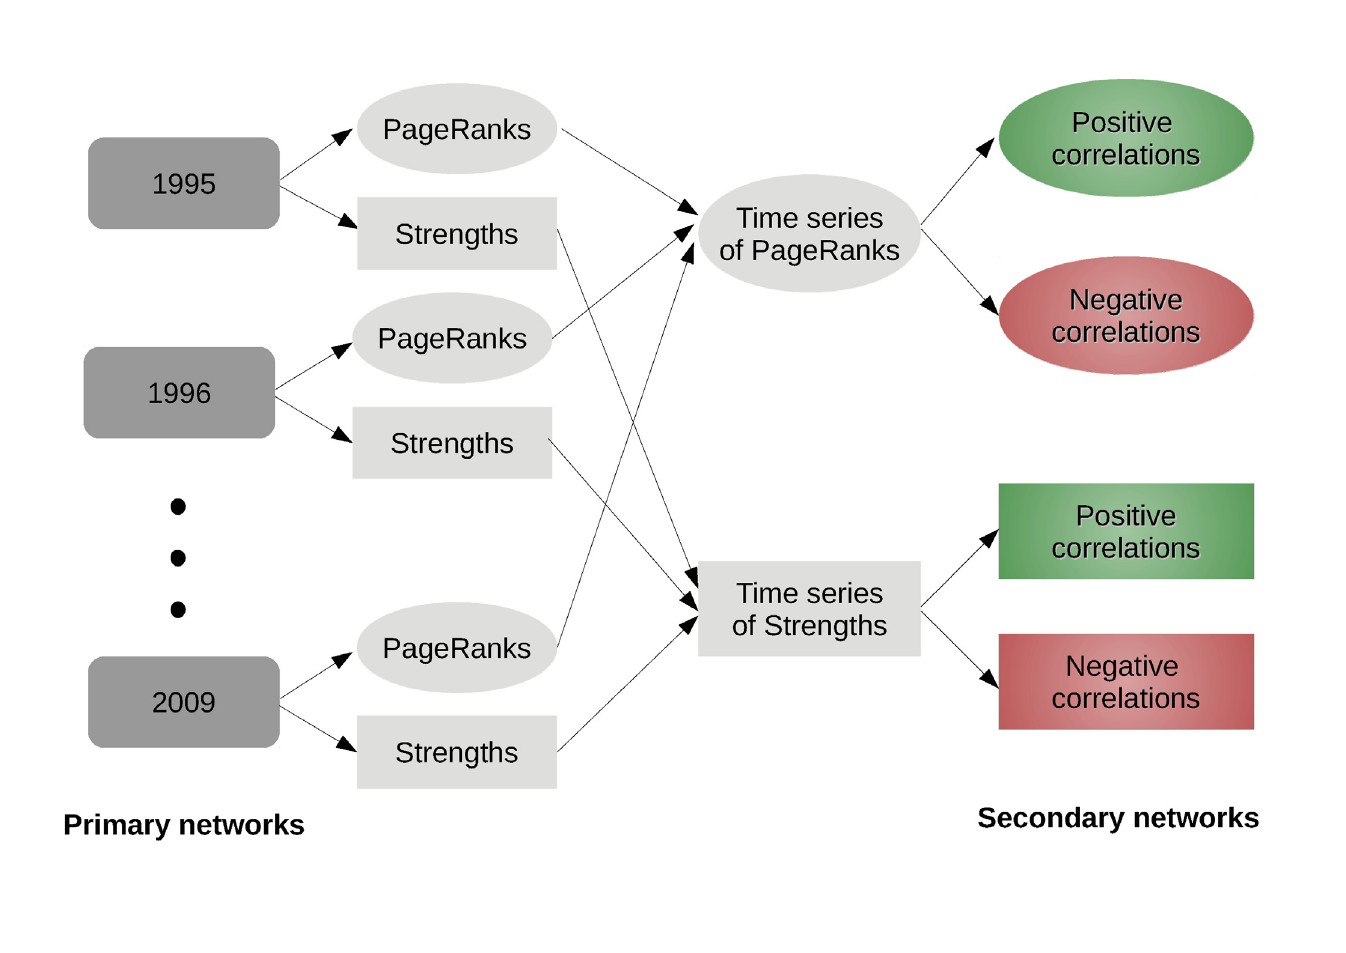
Fig 1. How do we form the secondary networks? We start with primary networks where nodes are countries and the links are total annualexports from one country to the other. We form 15 such networks for each year starting from 1995 until 2009. We calculatePageRanks and Strength of each country in these networks and form time series of PageRanks and Strengths for each country. Finally we calculatepositive and negative correlationsbetweenthese time series and form 4 different secondary networks, where nodes are countriesand links are one of the following:positive correlations betweenPageRanks series, negative correlations betweenPageRanks series, positive correlationsbetweenStrengths series or negativecorrelationsbetweenStrengths series. We repeat the same procedurefor the